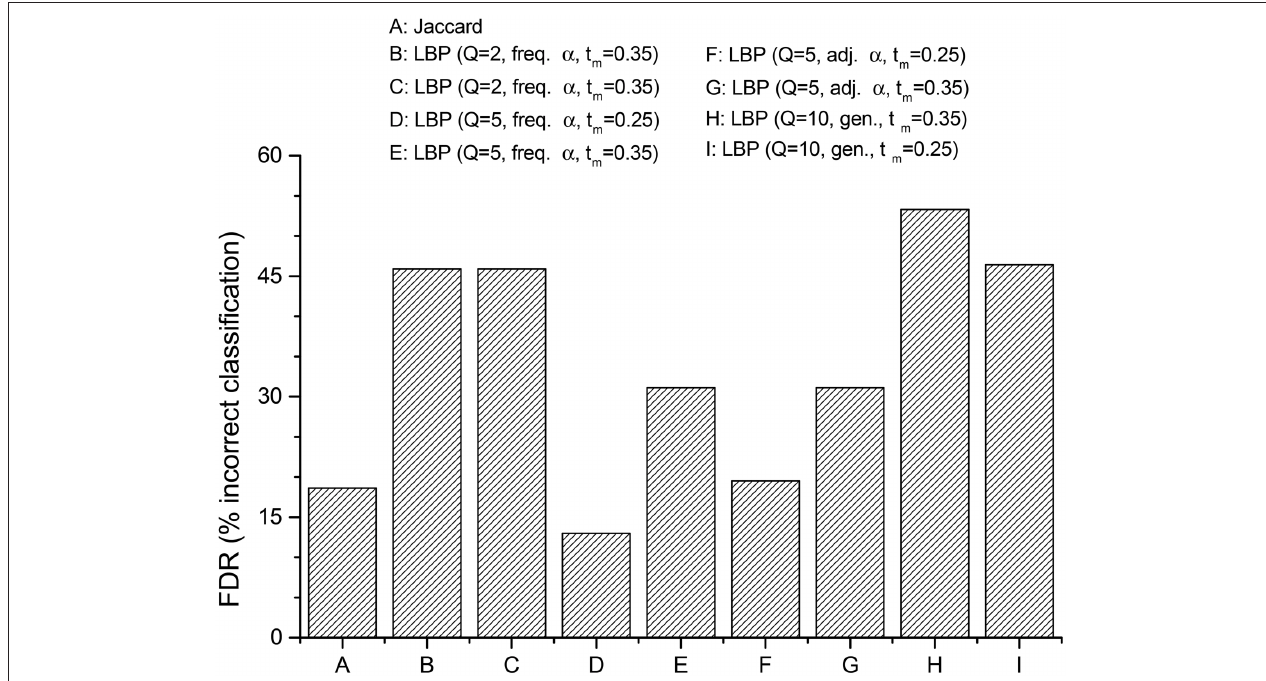
FIGURE 3 | Percentages of senators mistakenly classified in the “wrong” Senate political community (FDR, see Section 3), for different network reconstruction methods. Jaccard-reconstructed network is reported for reference. Parameters used for each case are in the Legend.